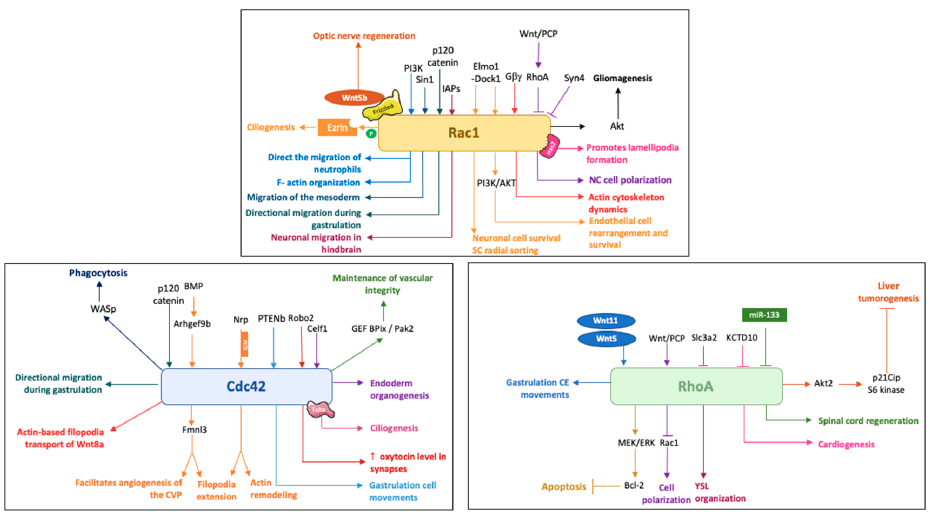
Figure 2. Schematic illustration of the main activities of Rac1, Cdc42 and RhoA in zebrafish and some of their regulators. NC, Neural Crest; SC, Schwann cell.